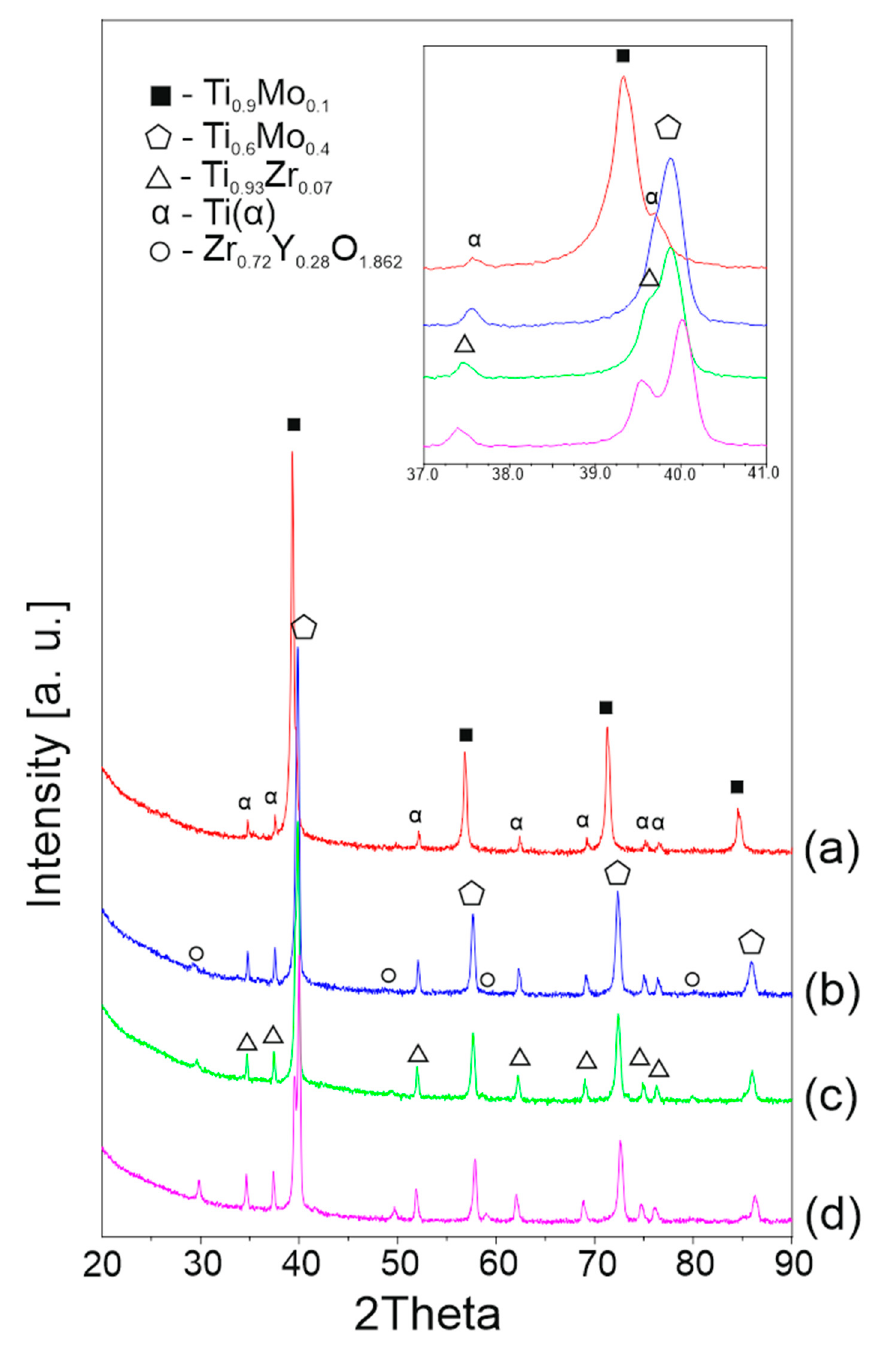
Figure 7. XRD patterns of 35 ( a ), 35–3 ( b ), 35–5 ( c ), 35–10 ( d ) after sintering.